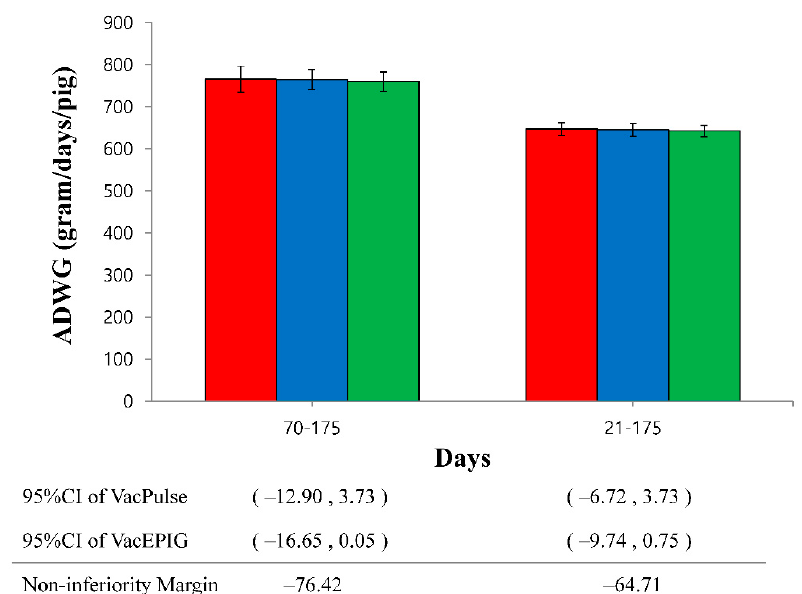
Figure 1. Non-inferiority analysis of average daily weight gain (ADWG) for 2 needle-free devices (VacPulse group • , and VacEPIG group, • ) during fattening period (70 to 175 days) and overall period Figure 1. Non ‐ inferiority analysis of average daily weight gain (ADWG) for 2 needle ‐ free devices (21 to 175 days) as compared with conventional needle-syringe (VacS group, • ). The lower bound of (VacPulse group ● , and VacEPIG group, ● ) during fattening period (70 to 175 days) and overall the one-sided 95% confidence intervals (CI) was greater than the margin of non-inferiority, indicating period (21 to 175 days) as compared with conventional needle ‐ syringe (VacS group, ● ). The lower bound of the one ‐ sided 95% confidence intervals (CI) was greater than the margin of that two needle-free devices were non-inferior to conventional needle-syringe. non ‐ inferiority, indicating that two needle ‐ free devices were non ‐ inferior to conventional nee ‐ dle ‐ syringe.